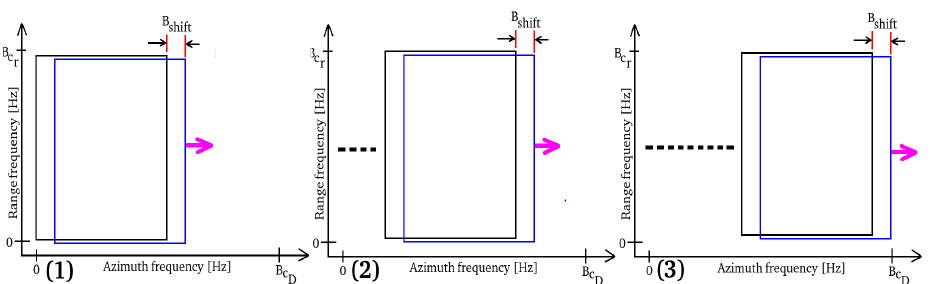
Figure 2. Doppler sub-aperture strategy. ( 1 ) Spectrum explored from the beginning. ( 2 ) Spectrum explored from the middle. ( 3 ) Finally explored spectrum.